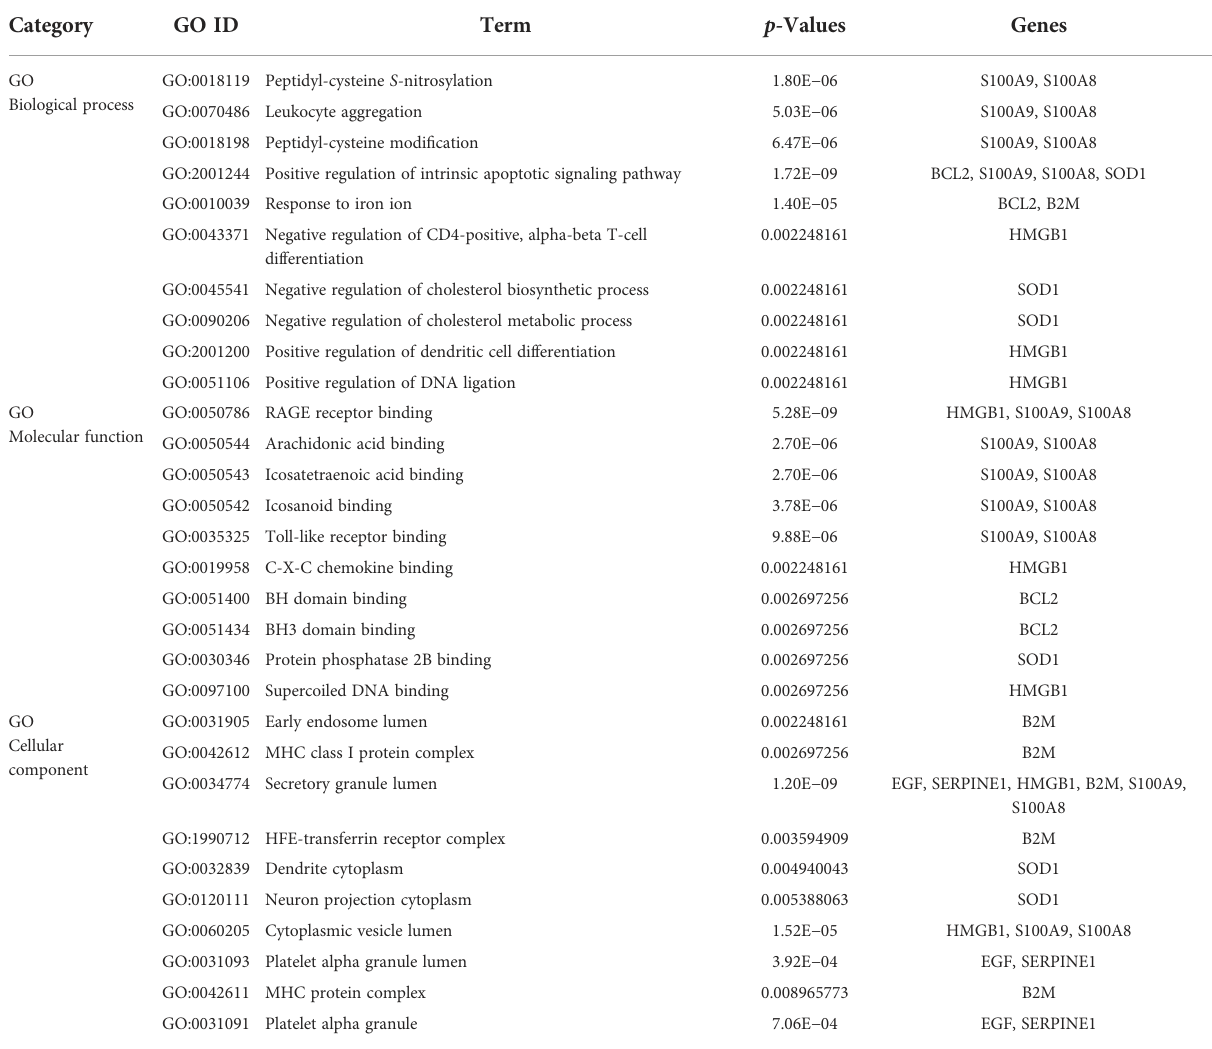
TABLE 2 Ontological analysis of common genes among Long COVID and ME/CFS.